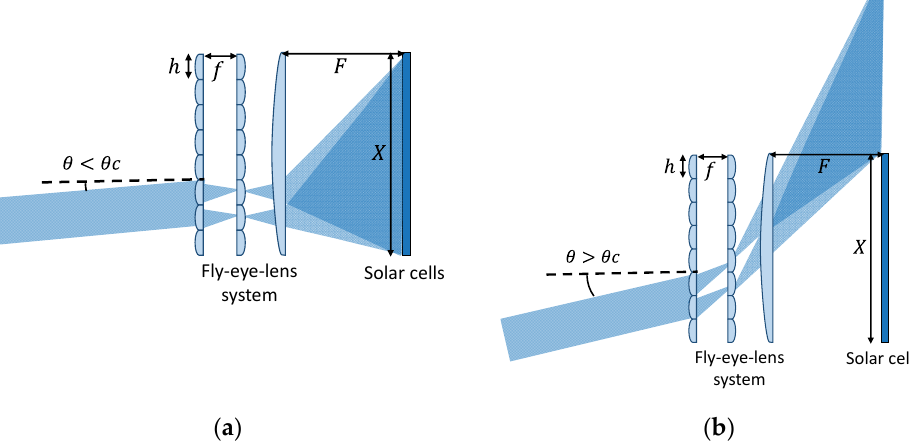
Figure 7. Oblique incidence on the fly-eye lens system ( a ) within the allowable incident angle ( b ) over the allowable incident angle.